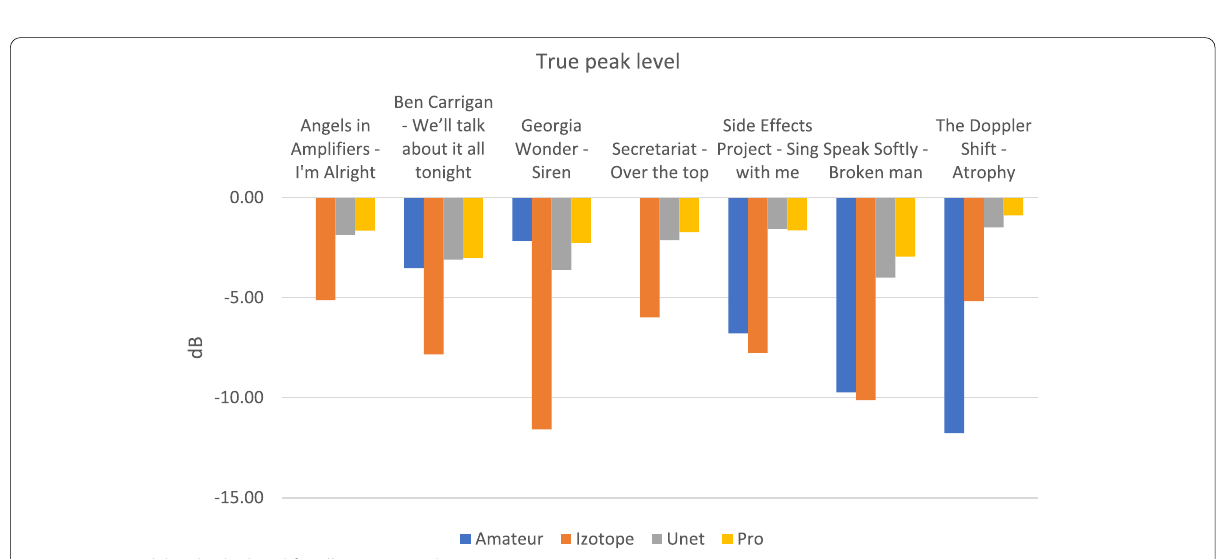
Fig. 7 True peak level calculated for all music